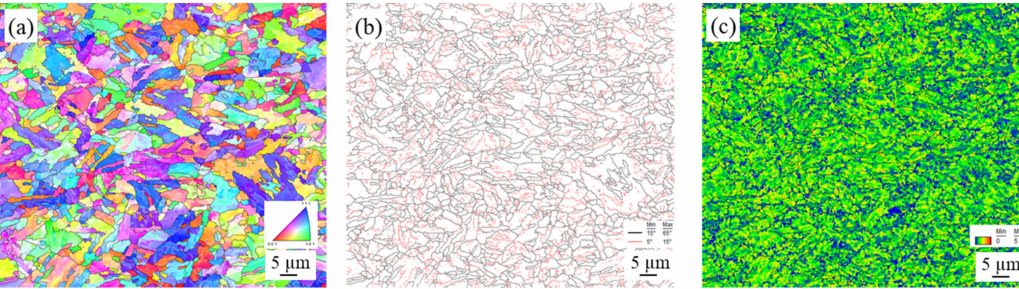
Figure 13. EBSD characterization at the representative FG area near the top surface of sample C: ( a ) inverse pole figure; ( b ) grain boundary; and ( c ) KAM.